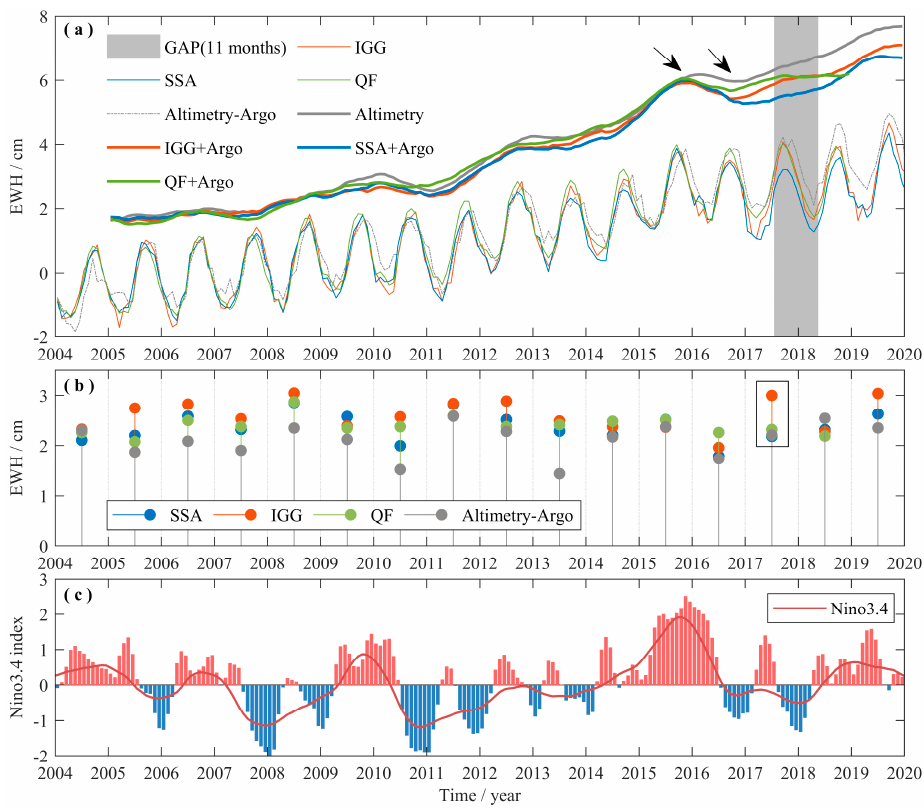
Figure 8. Comparisons of time series of global sea level anomalies. ( a ) Global mean sea level anomalies. QF, IGG, and SSA represent the seawater mass changes and Altimetry-Argo is the altimetry result minus the steric sea level change (note that seasonal signals remain in these data). Altimetry, SSA + Argo, IGG + Argo, and QF + Argo denote the corresponding total sea level changes after 12-month sliding average. ( b ) Annual variations in mean seawater mass. ( c ) Time series of Nino3.4 indicators. The bars and curves represent the monthly values and the series after 12-month sliding average, respectively.